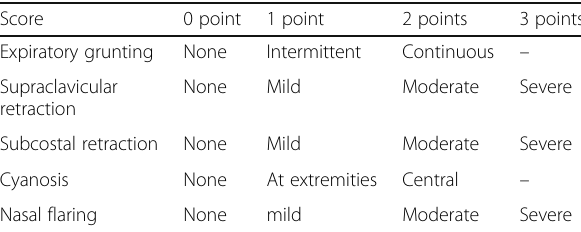
Table 2 Demographic data of study groups and maternal risk